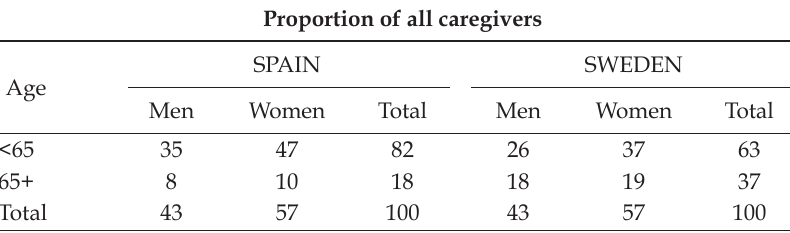
Proportion of all caregivers